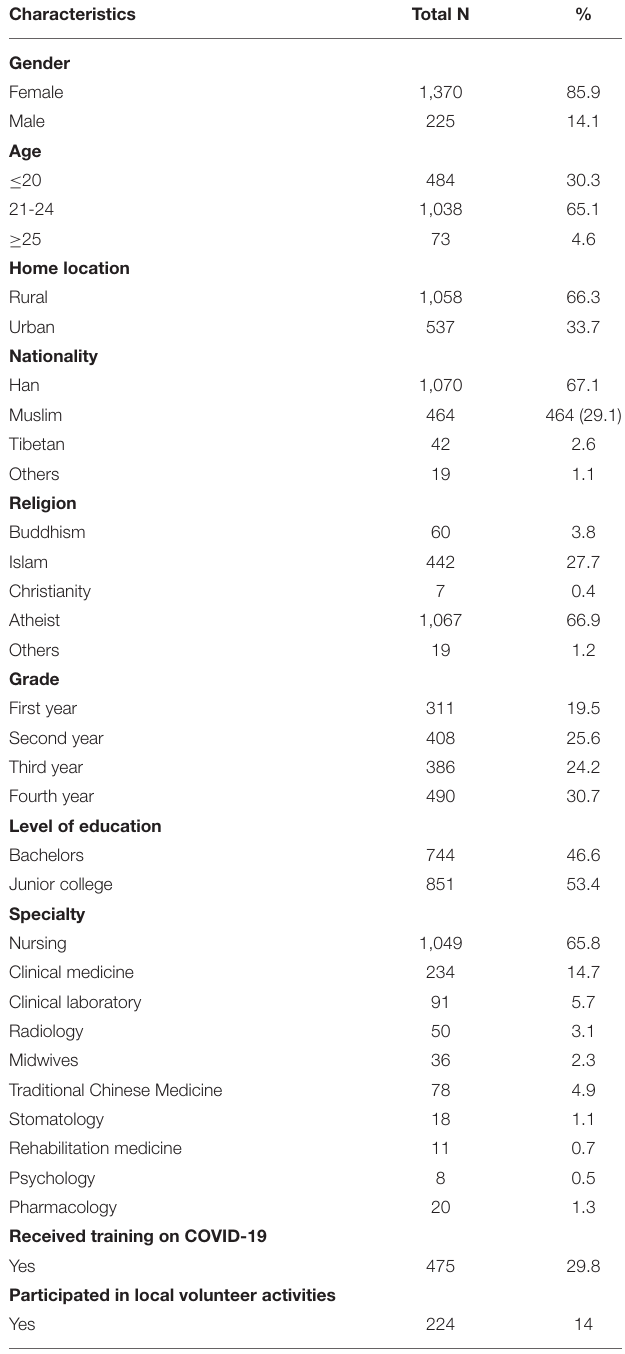
TABLE 1 | Demographics of included students (N =